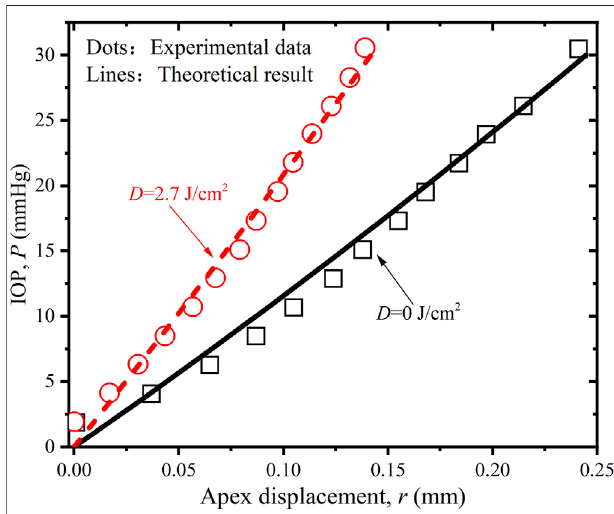
FIGURE 5 | Comparison of the P - r relations of porcine cornea between the experimental data (Boschetti et al., 2021) and simulated results when D (cid:1) 0J/cm 2 and 2 . 7J/cm 2 .